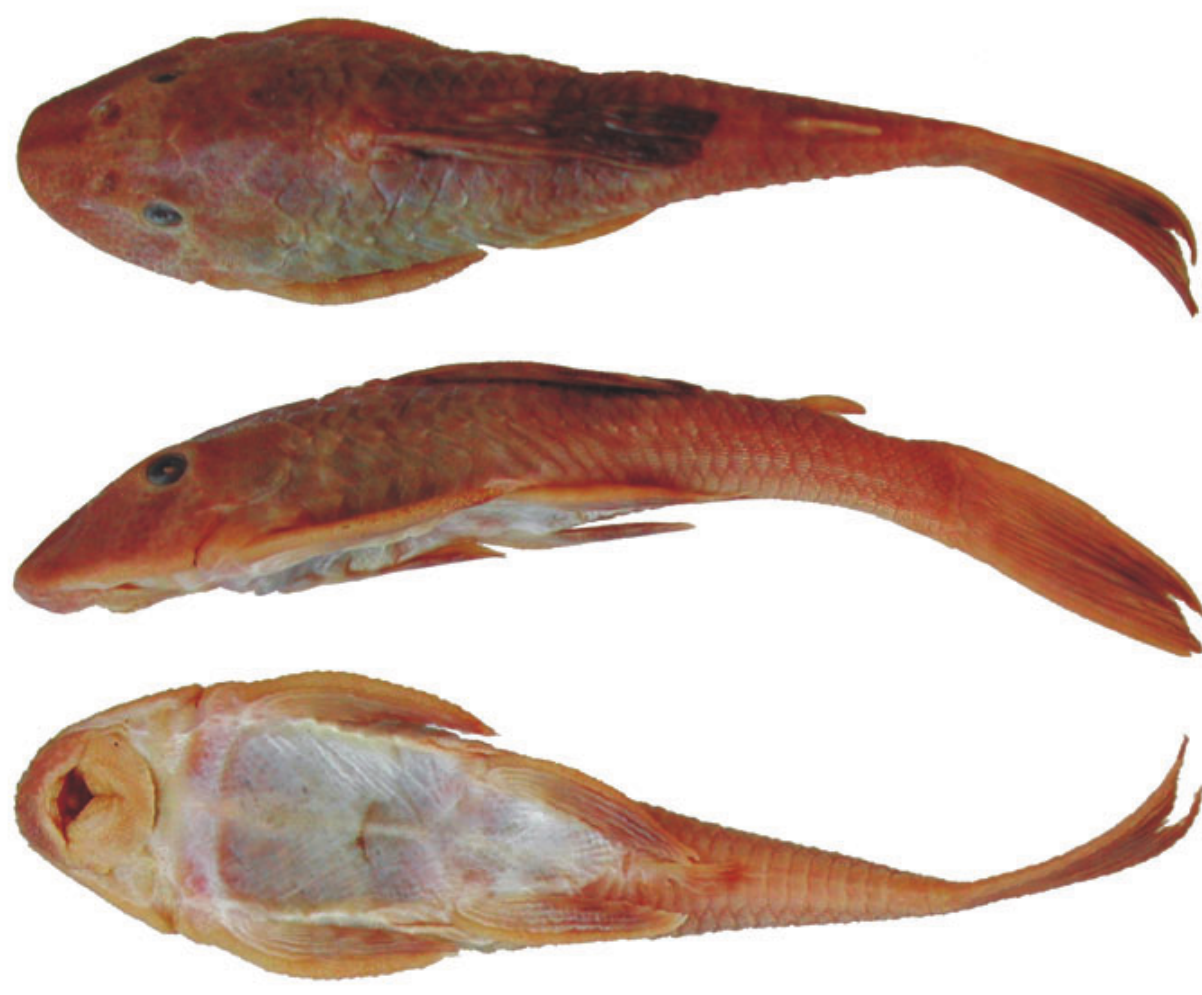
Fig. 3. Holotype of Hypostomus derbyi , FMNH 54246, 90.5 mm SL, Porto União da Victoria, currently Municipality of União